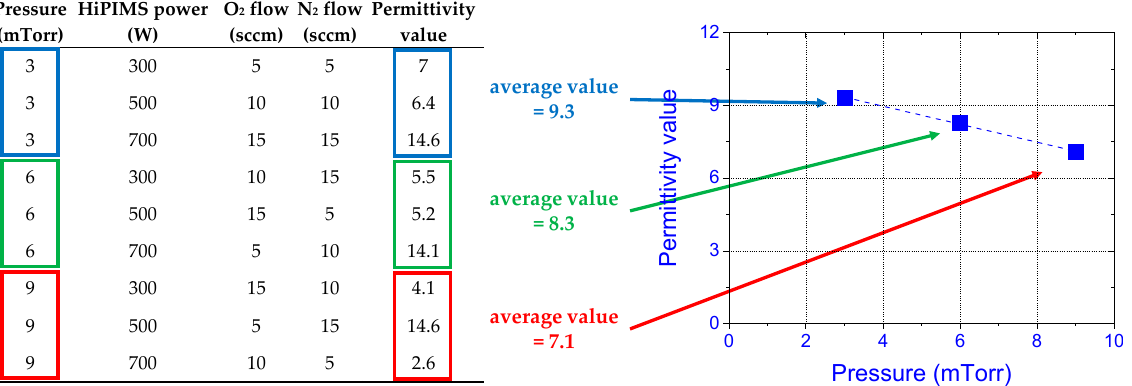
Figure 2. Most essential trends (dashed lines) obtained according to the Taguchi approach employed in this study, which are taken into account to set the ultimate process parameters for fabrication of HfO x N y layers. The trends presented in Figure 2 proved that increasing oxygen fl ow decreased the EOT value of a dielectric fi lm. Moreover, the lower oxygen fl ow increased the intensity of the electric fi eld, which caused the breakdown phenomenon; however, the trend was not a strong function of the O 2 fl ow. Simultaneously, the peak of the O 2 fl ow was observable, which led to high values of e ff ective charge and interface trap densities. Considering all analyzed trends, it was observed that the be tt er electrical parameters of the ultimate HfO x N y fi lm should be characterized by material deposited at higher oxygen fl ow. Thus, 20 sccm of oxygen fl ow was selected in the next step of the optimization procedure. As for the in fl uence of the pressure in the reactive chamber, the demonstrated trends pointed out that lower pressure correlated to higher permi tt ivity and higher breakdown